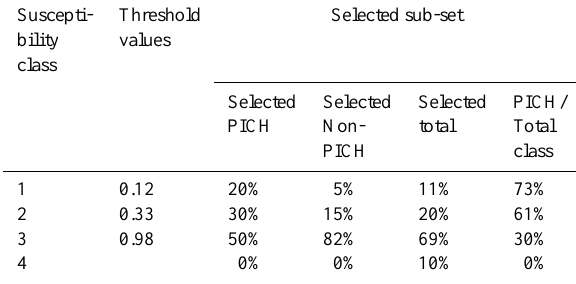
Table 5. Sorting efficiency based on the upstream watershed area.